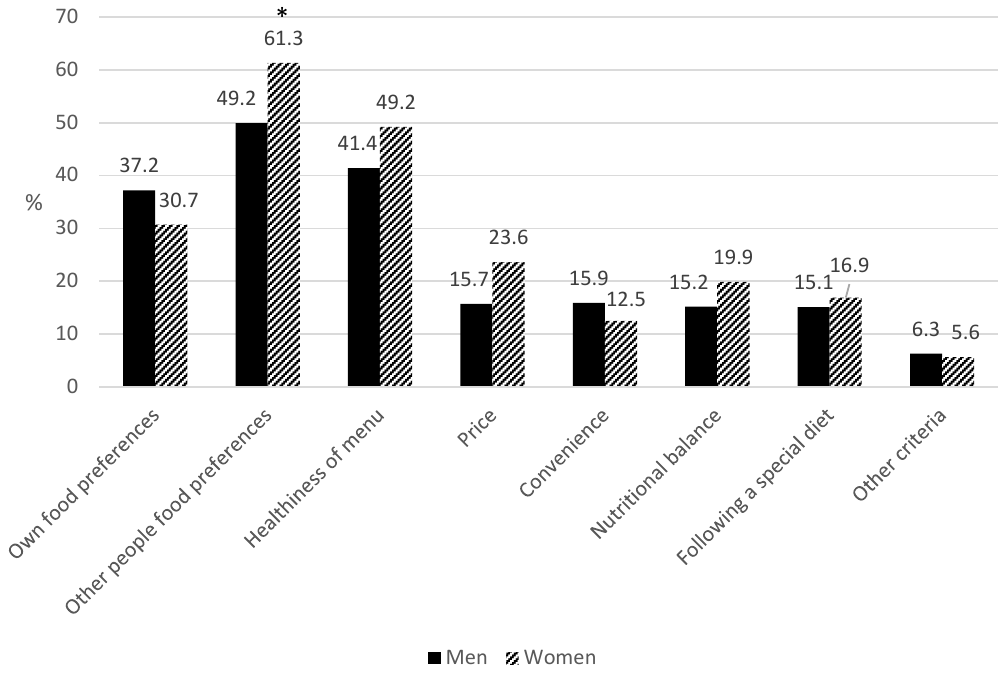
Figure 3. The main criteria when planning meals at home (%), by gender. The sample sizes by gender were as follows: n = 406 men; n = 890 women; * p < 0.05, women vs. men.